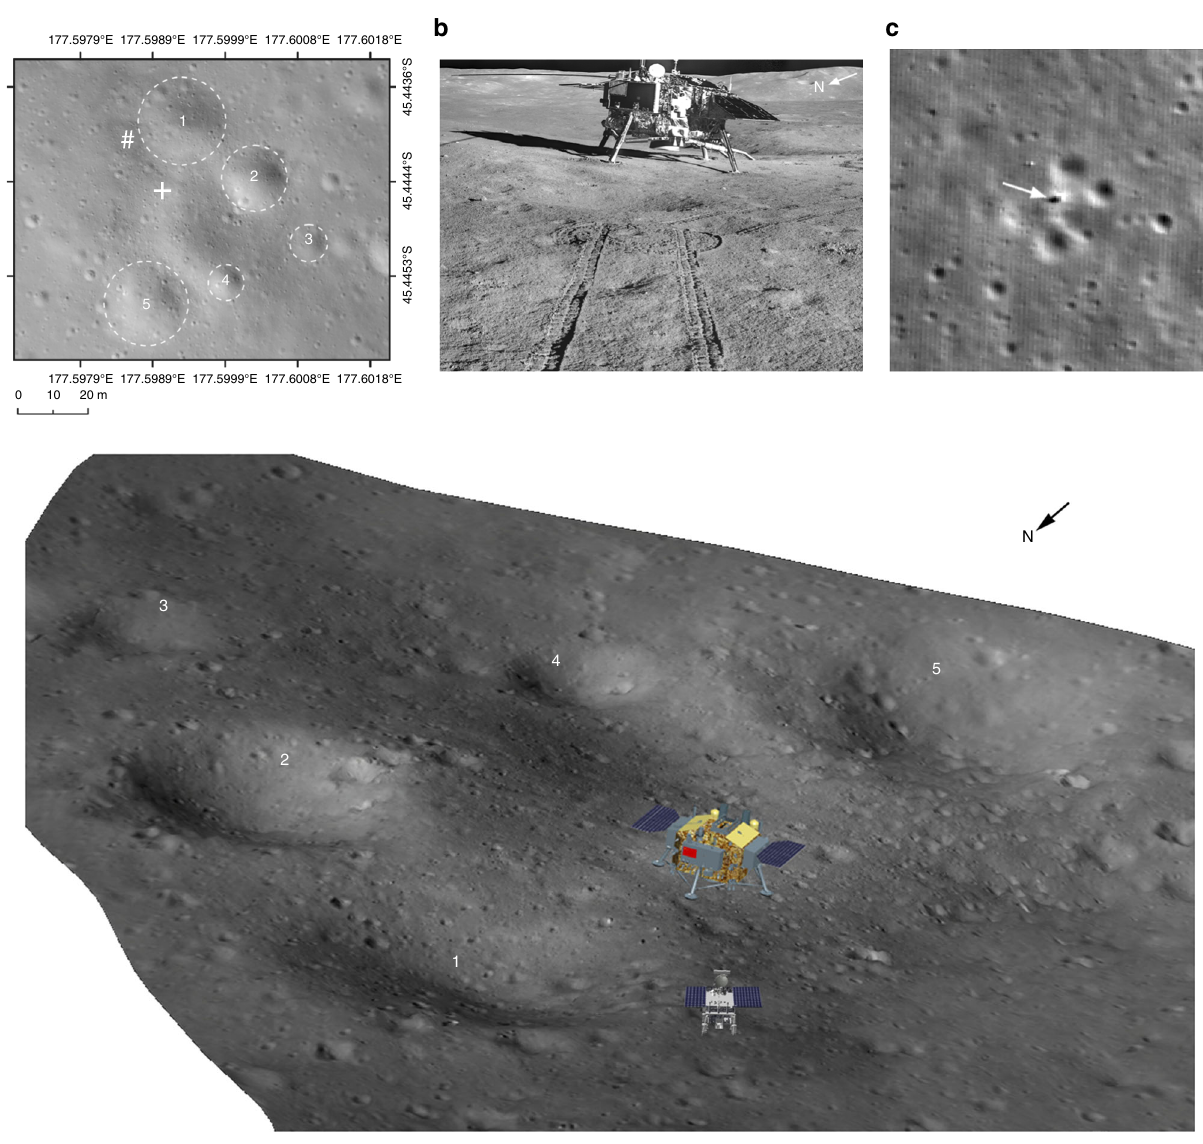
Fig. 5 Position of the CE-4 landing site. a The CE-4 landing site on the 5 cm/p resolution LCAM DOM, in which the + is the identi fi ed landing location and the # is the location of Yutu-2 on 12 January 2019. Five prominent craters around the landing site are marked. ( b ) CE-4 lander image obtained from the northwest of the landing site by the Yutu-2 PCAM at the location labeled in ( a ). ( c ) LRO NAC image of the CE-4 landing site collected on 1 February 2019 (M1303640934LR), in which the arrow indicates the location of CE-4 landing site. ( d ) Three-dimensional landscape map of the landing site generated by the DEM and DOM data through reconstruction of CE-4 LCAM sequential images acquired within 100 m above the lunar surface, in which the location of CE-4 lander and Yutu-2 is the same as labeled in ( a ). While landing position was determined from LCAM orbital data ( a ), the orientation of the lander was determined using PCAM image taken from the ground ( b ). Prominent craters are also marked in ( d ), as in ( a ) overlaps of the LCAM images, were extracted. The relative positional relationship of these images can be precisely restored according to these tie points. Facilitated by one LRO NAC image (M178833263LC), 13 evenly distributed GCPs close to the landing site (including 12 horizontal and vertical GCPs and 1 vertical GCP) were extracted from the CE2TMap2015 map and LCAM images. The centers of some easily recognized small craters were mainly selected to ensure the selection accuracy of the GCPs. According to photogrammetric bundle adjustment theory 22,23 , the relationship between the lunar surface points, the corresponding image points and the camera projection center can be expressed by the classical collinear equation, which is as follows. Fig. 6 Elevation variations of the lunar terrain along the CE-3 and CE-4 nadir fl ight traces. The blue and orange lines represent the elevation variation for the CE-3 and CE-4 nadir fl ight trace, respectively. Elevation is given with where ( x , y ) are the image coordinates of the feature points, ( x 0, y 0) are the image respect to the Moon ’ s spheroid with a radius of 1737.4 coordinates of the image principal point, ( Δ x , Δ y ) are self-calibration correction